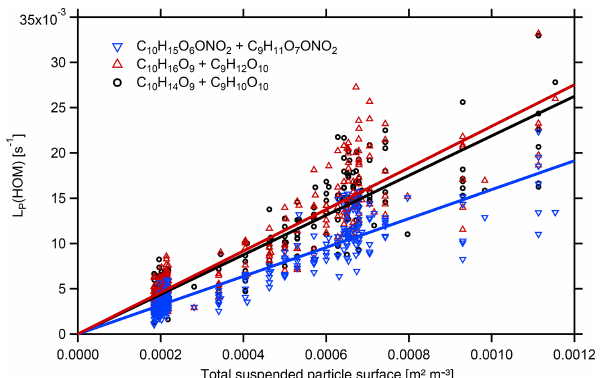
Figure 5. Plot of L P (HOM) calculated by Eq. (6) versus particle surface area, S P , for the examples of HOM-ONs with a molecular mass of = 293Da (C 10 H 15 O 6 ONO 2 and C 9 H 11 O 7 ONO 2 ), HOM-PPs with a molecular mass of 280Da (C 10 H 16 O 9 and C 9 H 12 O 10 ), and HOM-PPs with molecular mass of 278 (C 10 H 14 O 9 and C 9 H 10 O 10 ). HOMs from β -pinene pho- tooxidation ([ β -pinene] SS ∼ 10ppb, [NO x ] SS ∼ 4ppb). Dividing the slopes by the respective ˜ v/ 4 led to f FS × γ eff ∼ 0 . 5 for the exam- ple HOM-ONs and ∼ 0 . 6 in the latter cases. The main uncertainty arises from the scatter of L P (HOM) individual unit mass resolution data. Statistical errors of f FS × γ eff were about ± 5%.